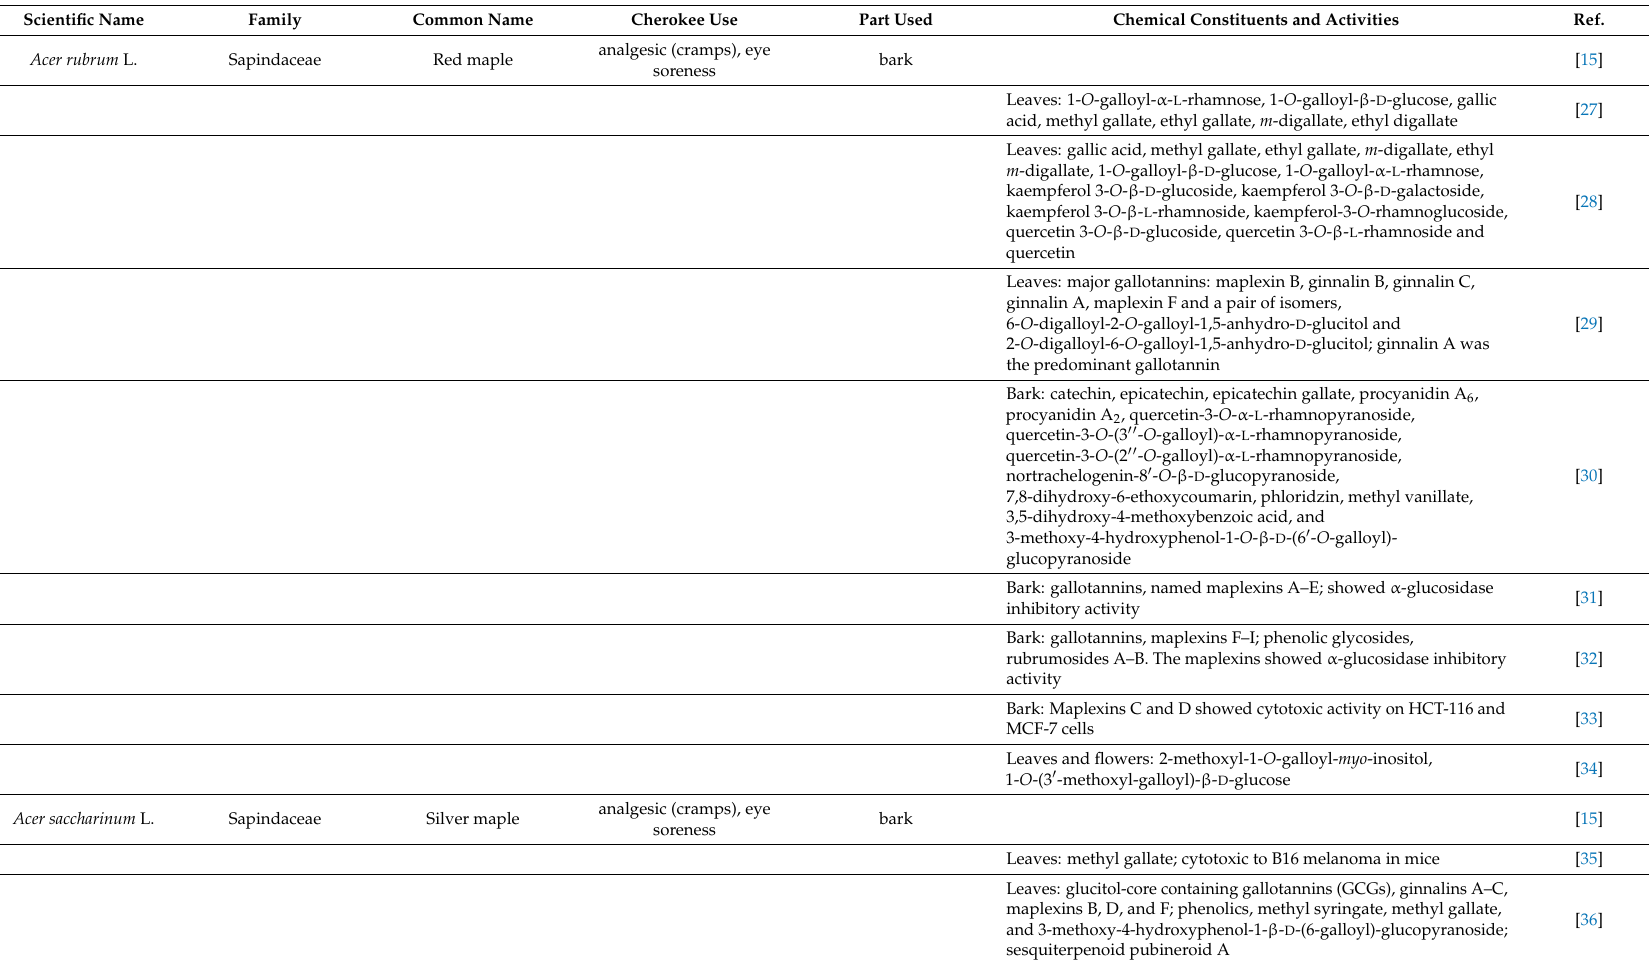
Table 1. List of Cherokee aromatic medicinal plants, their traditional uses, and phytochemical constituents and biological